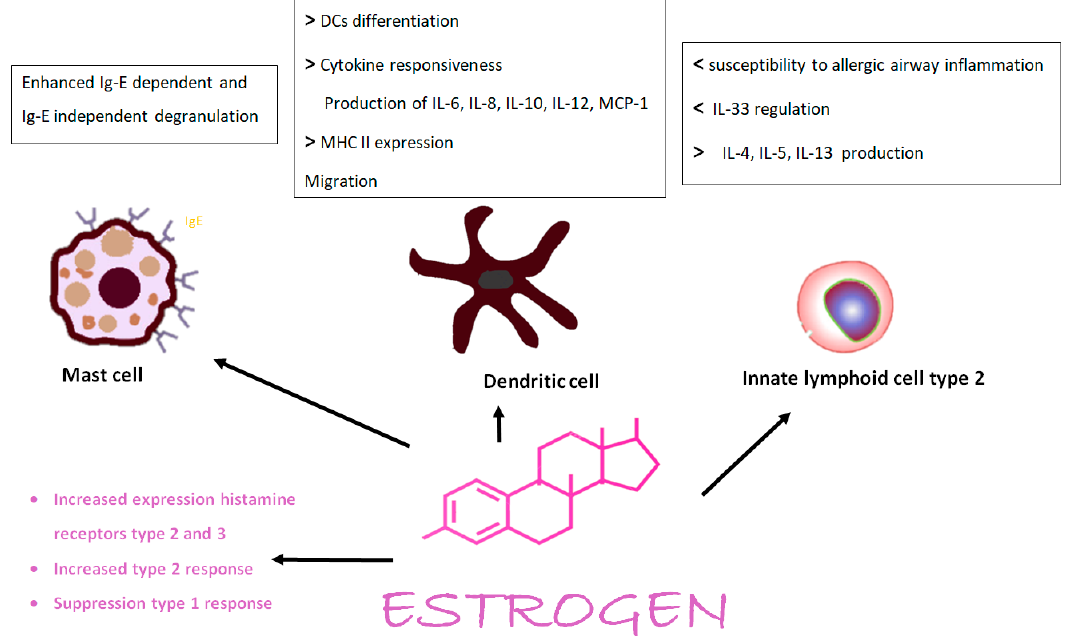
Figure 3. Estrogen’s influences on